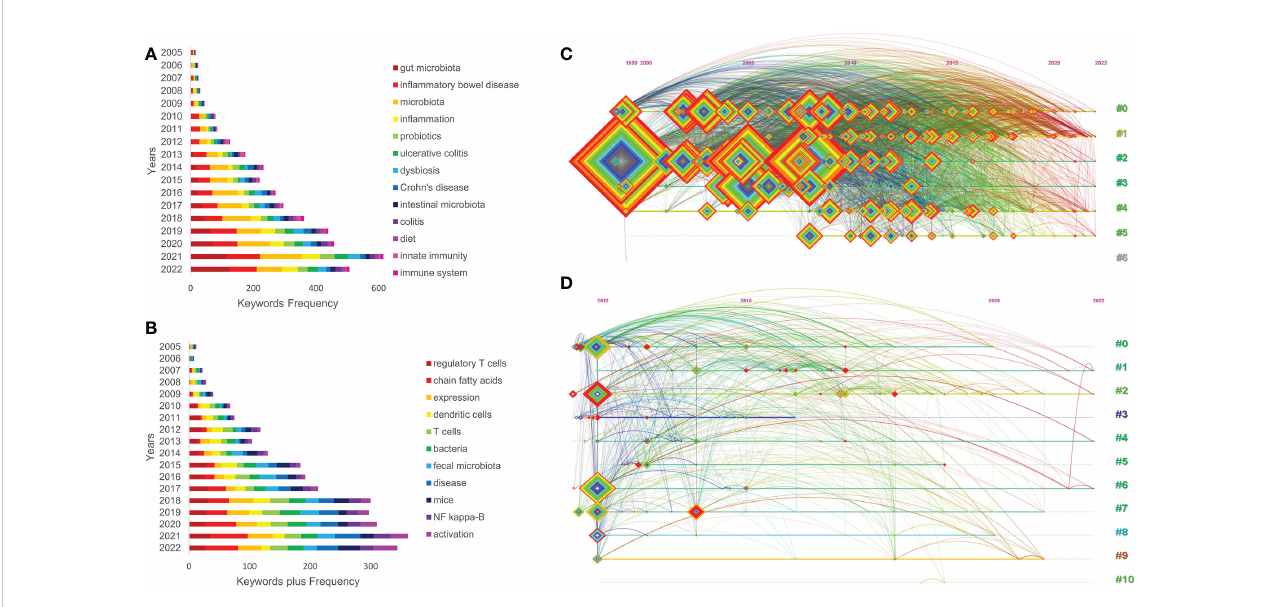
FIGURE 6 Annual number of common keywords (A, B) , the clustering timeline view of keywords (C, D) of relevant literature. ( A, B, C : all relevant literature; D : citation